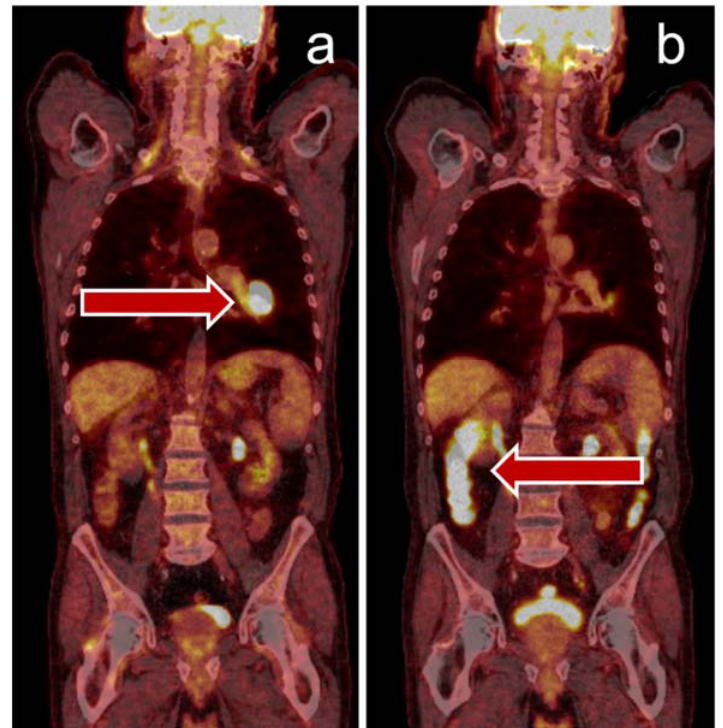
Figure 2. Immune ‐ related colitis visualized by PET/CT: 71 ‐ year ‐ old man with stage IV NSCLC, left hilum (PD ‐ L1 90%) with cervical lymph node metastasis that was surgically removed for histological analysis ( a ). After three cycles of pembrolizumab, the patient underwent a follow ‐ up PET/CT scan for evaluation of possible radiotherapy and reported persistent diarrhea. PET/CT scan showed a major tumor response and increased uptake in the colon region consistent with immune ‐ mediated colitis ( b ). Colonoscopy and histological specimens supported this diagnosis, the patient responded to corticosteroid treatment, immunotherapy was paused. NSCLCL non ‐ small ‐ cell lung cancer.